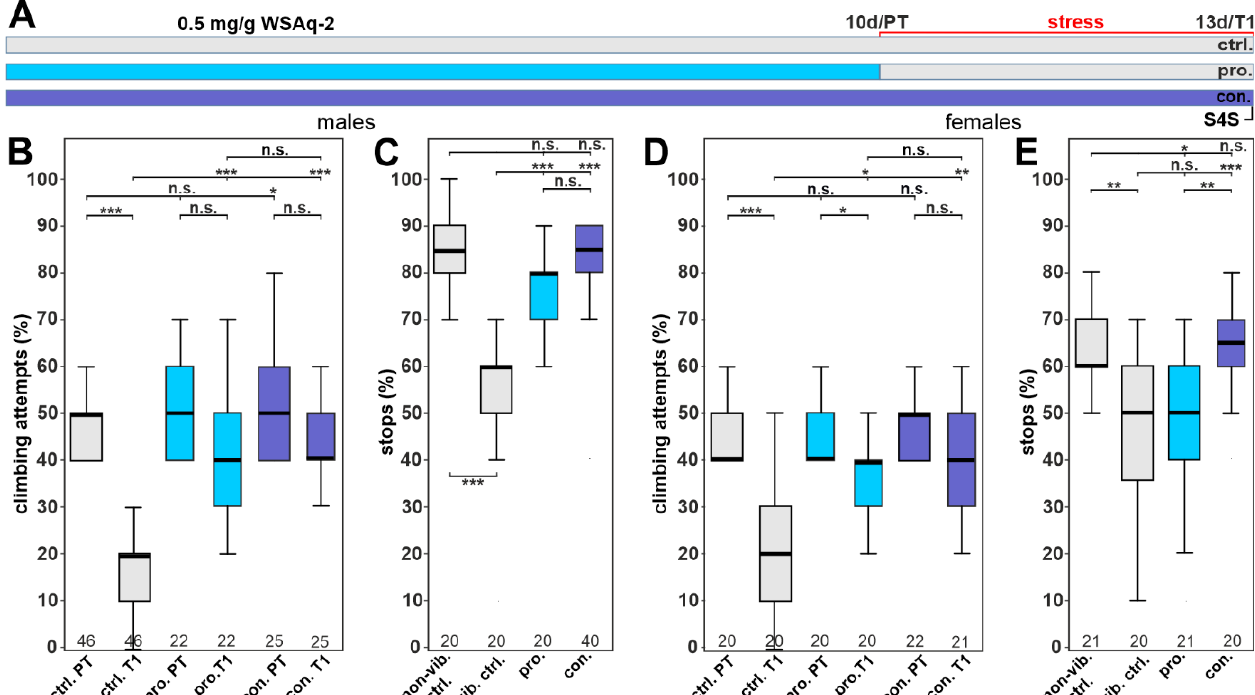
Figure 7. WSAq-2 protects against stress-induced behavioral phenotypes. ( A ) Schematic of the treat- ment paradigm (the time of WSAq-2 0.5 mg/g treatment) is indicated in blue/purple. ( B ) Percent of climbing attempts of males before (PT) and after (T1) stress was applied. ( C ) Number of stops males made at the sweet-tasting stripe. ( D ) Percent of climbing attempts of females before (PT) and after stress (T1) was applied. ( E ) Number of stops females made at the sweet-tasting stripe. A pairwise Wilcoxon test with Bonferroni–Holm correction for multiple comparisons was used in each panel. The number of analyzed flies is given below the boxes. The horizontal bars in the box plots represent the medians, boxes the 25% and 75% quartiles, and whiskers the data points within ± 1.5 times the interquartile range (IQR). Abbreviations: S4S = stop for sweet test, ctrl. = control, vib. ctrl = vibrated control, non-vib. ctrl. = non-vibrated control, pro. = prophylactic treatment, con. = continuous treat- ment. * p < 0.05, ** p < 0.01, *** p < 0.001, n.s. = not significant.